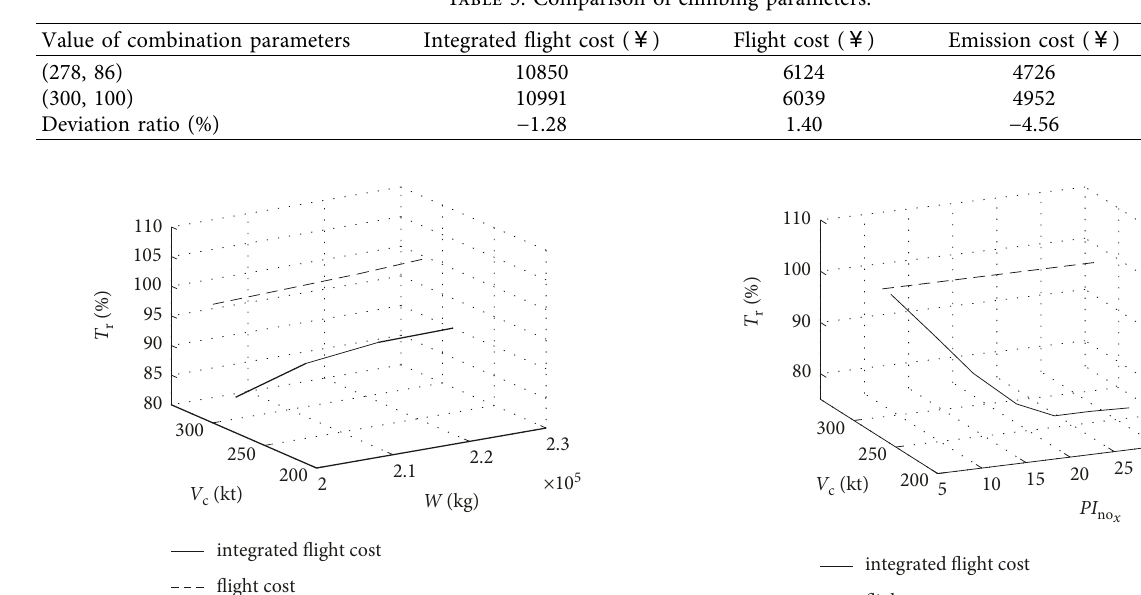
Table 3: Comparison of climbing parameters.